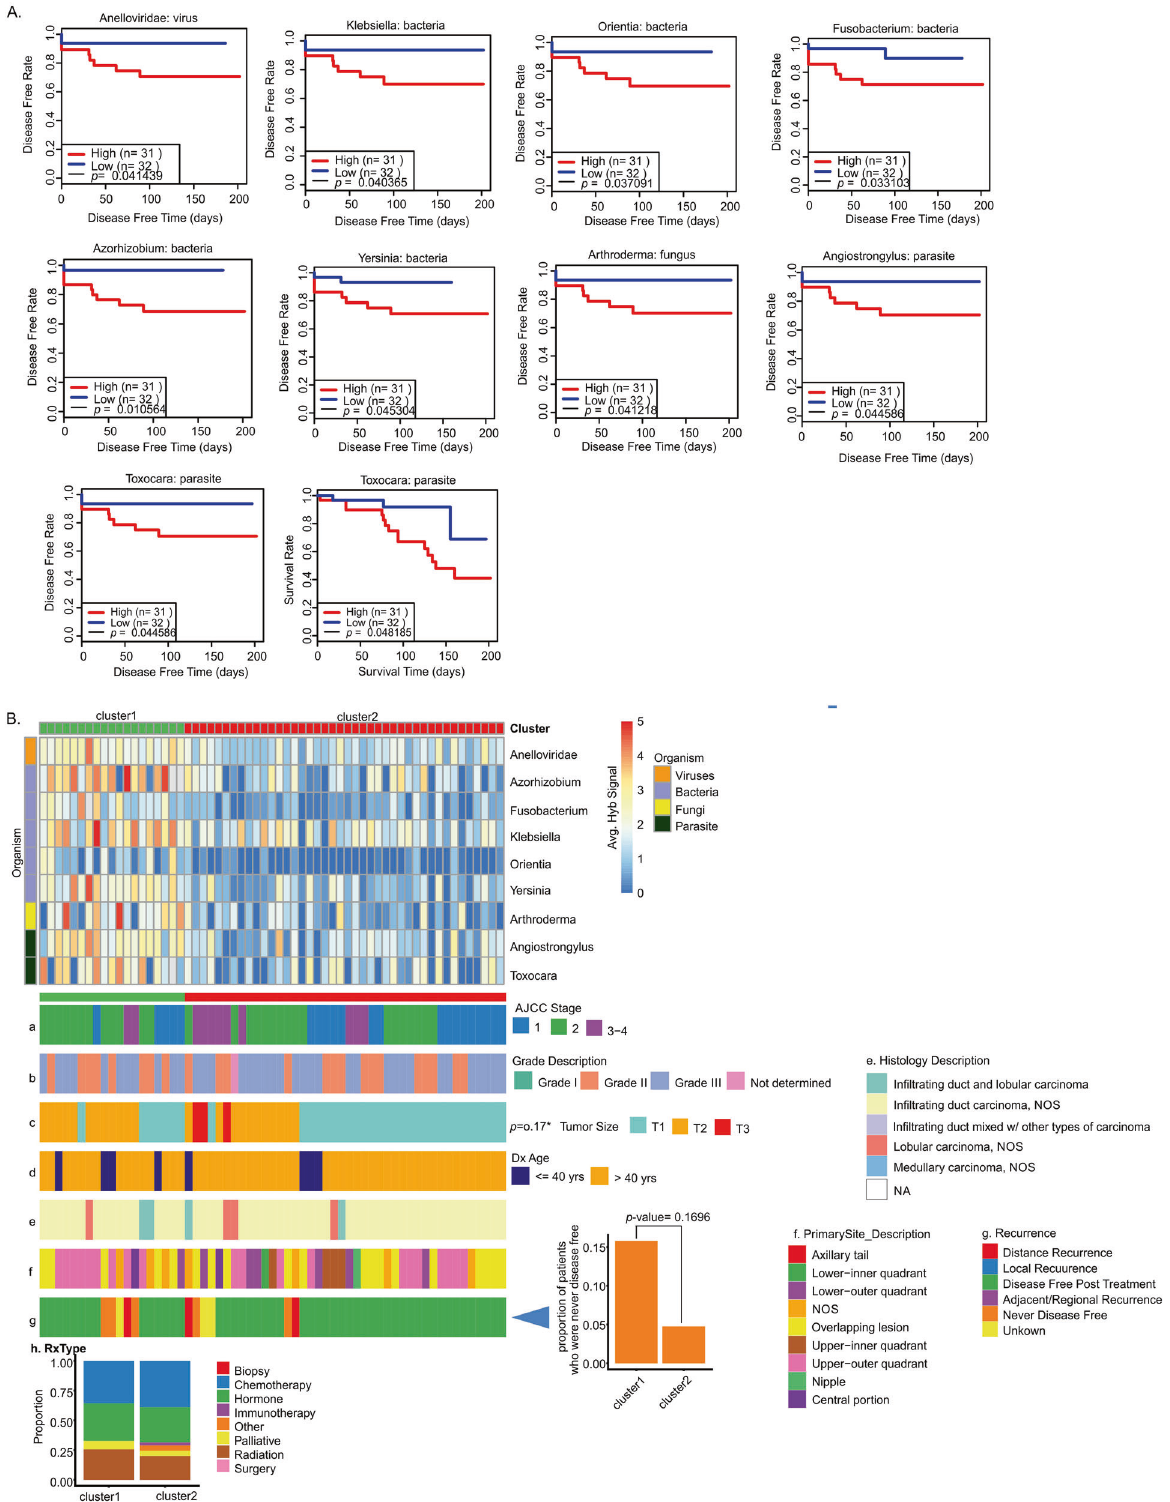
Fig. 8 Oncobiome signatures in TP + BCs where higher hybridization signals correlated with worse outcome. A The graphs show disease- free rate relative to high or low hybridization signals for speci fi c microorganisms in the tumor sample set. In the cases shown, higher hybridization signal correlated with decreased disease-free time. B The tumor samples were then clustered based on the hybridization levels for these microorganisms. The high (cluster 1) and the low (cluster 2) hybridization detection clusters correlated with other clinical data shown as horizontal ( a – g ) and vertical ( h ) cluster